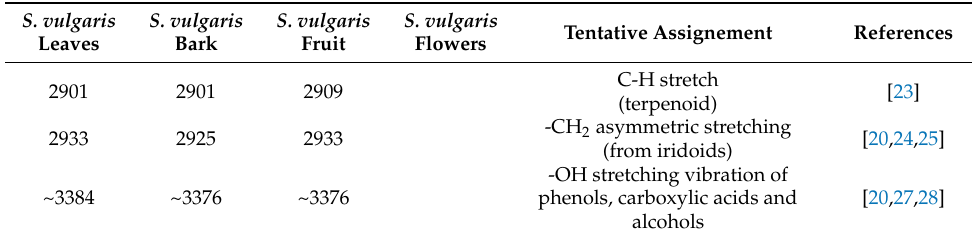
Table 3. Peak positions (cm − 1 ) and tentative assignments of FT-IR absorbance bands for Syringa vulgaris extracts from the leaves, bark, flowers and fruit recorded in the spectral region from 2000 to 4000 cm − 1 .